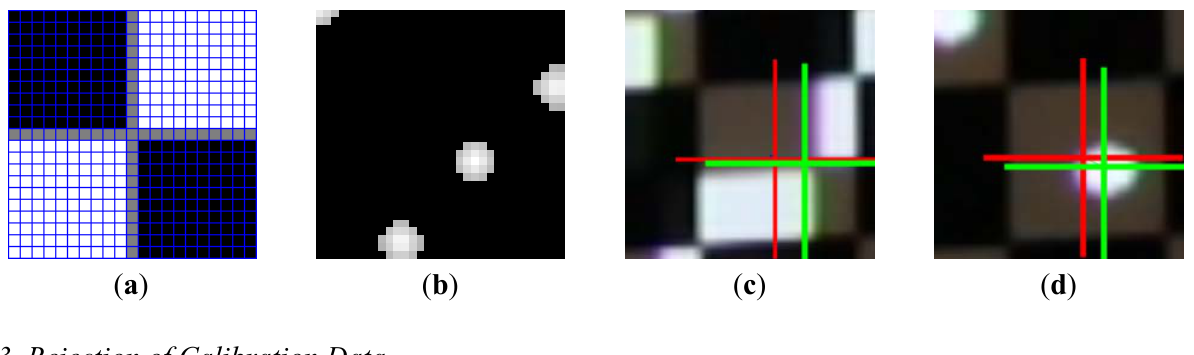
Figure 7. ( a ) Convolution kernel designed to respond corner feature. ( b ) Corner scores computed using convolution ( c ) Crosshairs showing the expected location (in red) and the actual location (in green) of a feature point. ( d ) The same algorithm without convolution can also be used to track spot